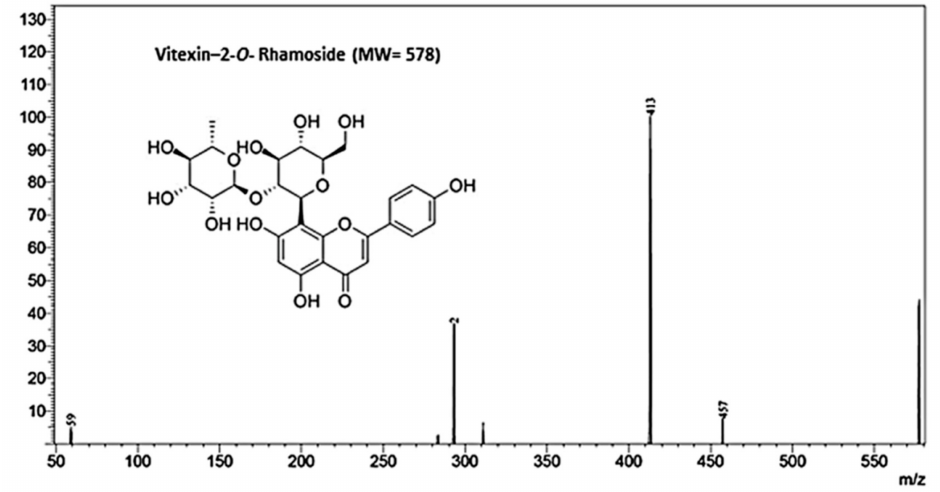
Figure 3. MS/MS fingerprinting of Vitexin-2- O -Rhamnoside, the main compound present in the ethanolic extract of beet stalks and